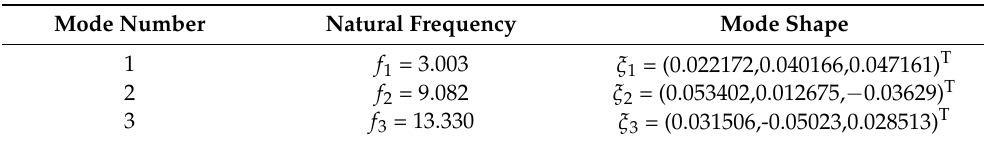
Table 8. Experimental modal data for damage case 2 (the first and second floors are both damaged Table 7. Experimental modal data for damage case 1 (the first floor is damaged by 11.6% stiffness by 21.1% stiffness reduction).